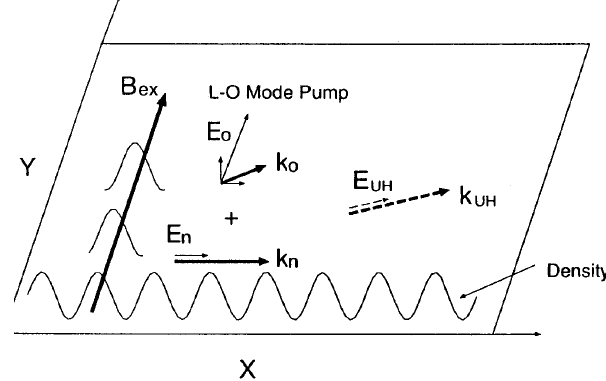
Fig. 2. Model of 2D electromagnetic particle simulation with periodic boundaries in x - and y -axes. The external magnetic field is taken along the y -axis. A density irregularity with coherent variation in the perpendicular direction ( x -axis) and an oblique L-O mode wave are assumed as the initial condition